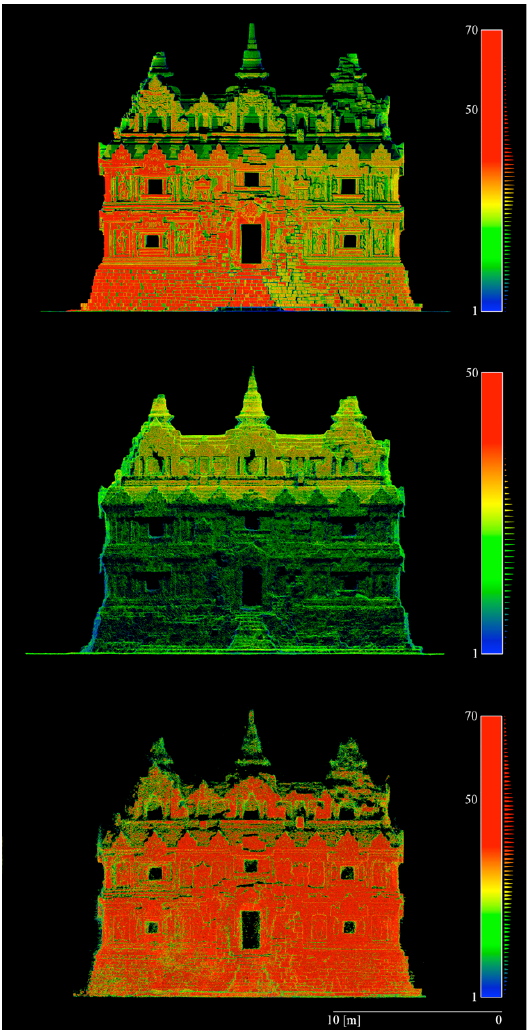
Figure 5. False-colour orthoview of the Candi Sari laser scanning (top), drone photo image match (middle) and handheld photo image match (bottom) point cloud representing the number of neighbours within a sphere of a radius r = 0.02m; red showing maximum density with 50+ neighbours 4.2.2 Imagematch drone: To complement the point cloud in areas that are hard to survey with a TLS, 77 drone images were taken to be processed into a point cloud of 19 million points by image matching (see Figure 4 right). The analysis of number of neighbours, analogous to the one done for the laser scanning data, clearly shows the focus that was directed to the upper parts of the Candi to cover the areas of less density in the laser scan. (see Figure 5 middle) Said regions also reach the 50+ number of neighbours, completing the whole exterior surface with a coverage of sub-mm